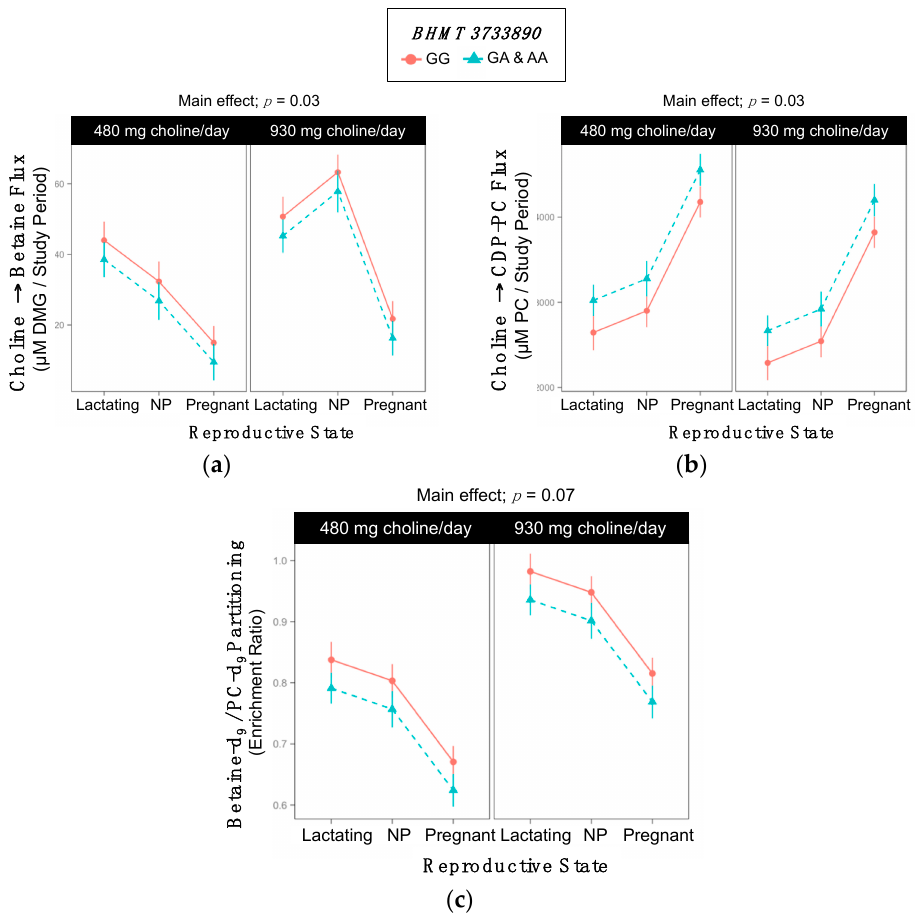
Figure 5. Effect of the BHMT rs3733890 variant on the metabolic flux and partitioning of dietary choline. ( a ) Choline → betaine flux; ( b ) Choline → CDP-PC flux; ( c) Betaine-d 9 /PC-d 9